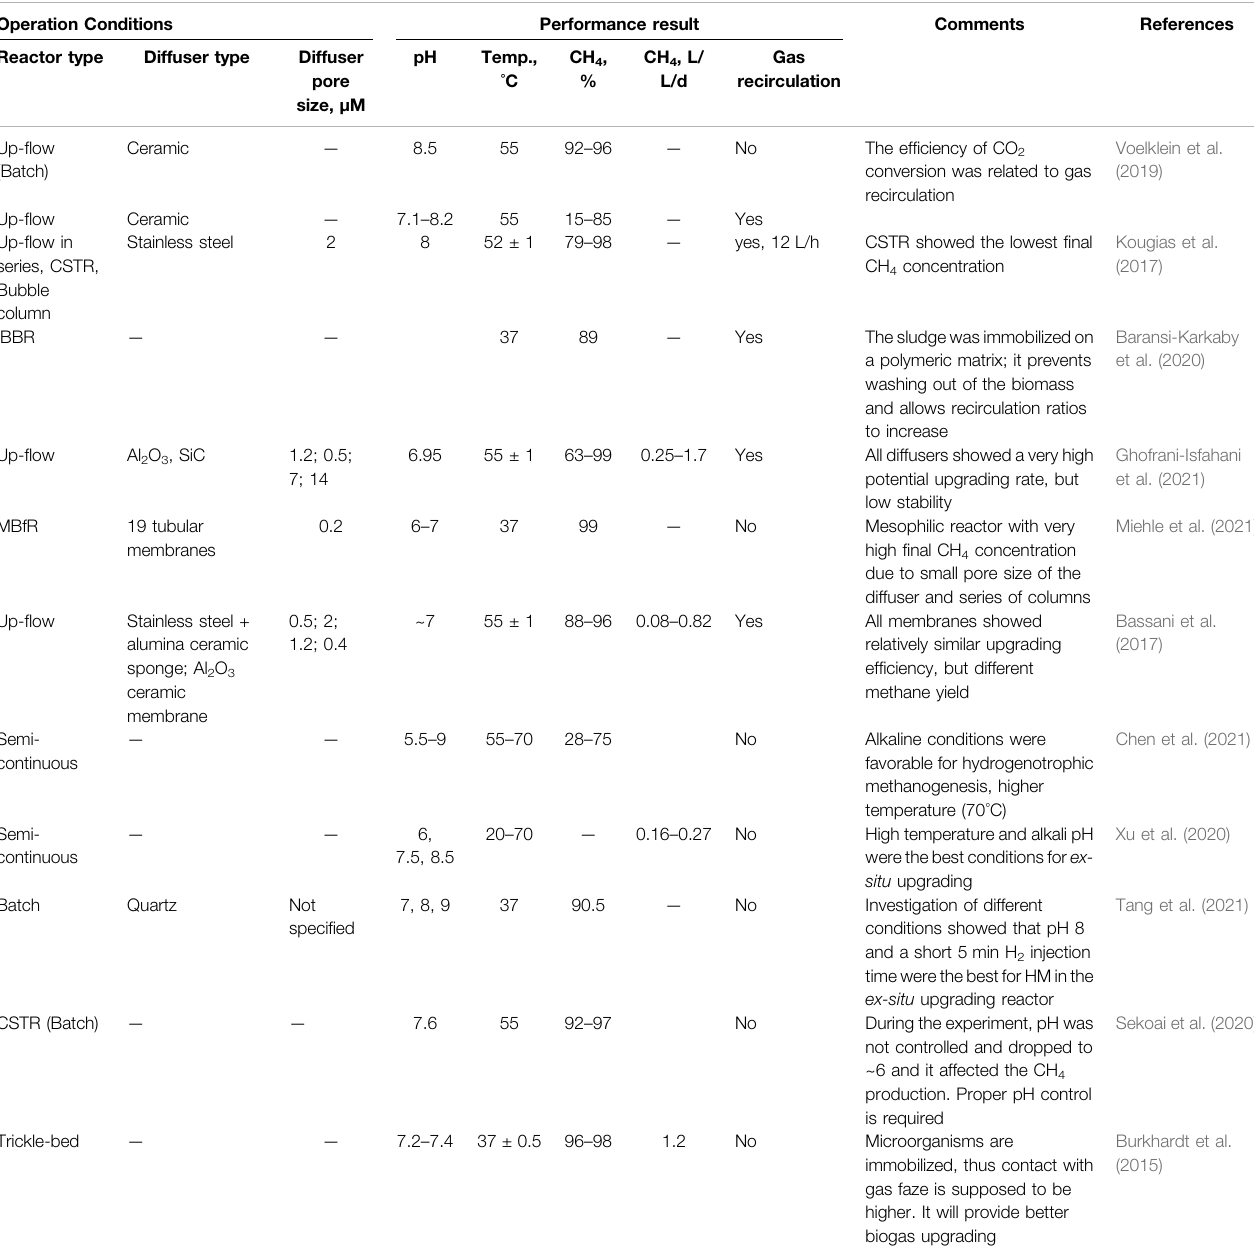
TABLE 2 | Comparison on the ef fi ciency of ex-situ methanation